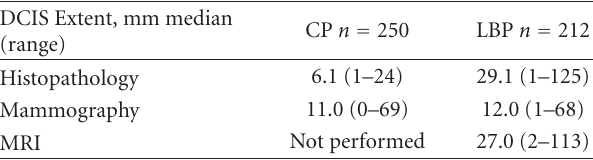
Table 6: Extent measurements of duct carcinoma in situ . Com- parison of 462 consecutive breast conserving surgical specimens. Conventional pathology without MRI (CP) versus large format breast pathology with MRI